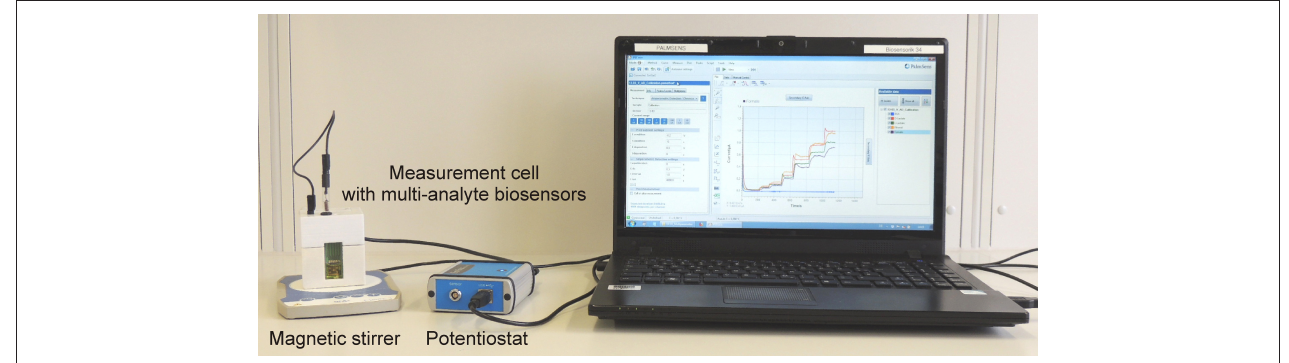
FIGURE 2 | Photograph of measurement set-up with biosensor and Ag/AgCl reference electrode connected to a potentiostat and software device.